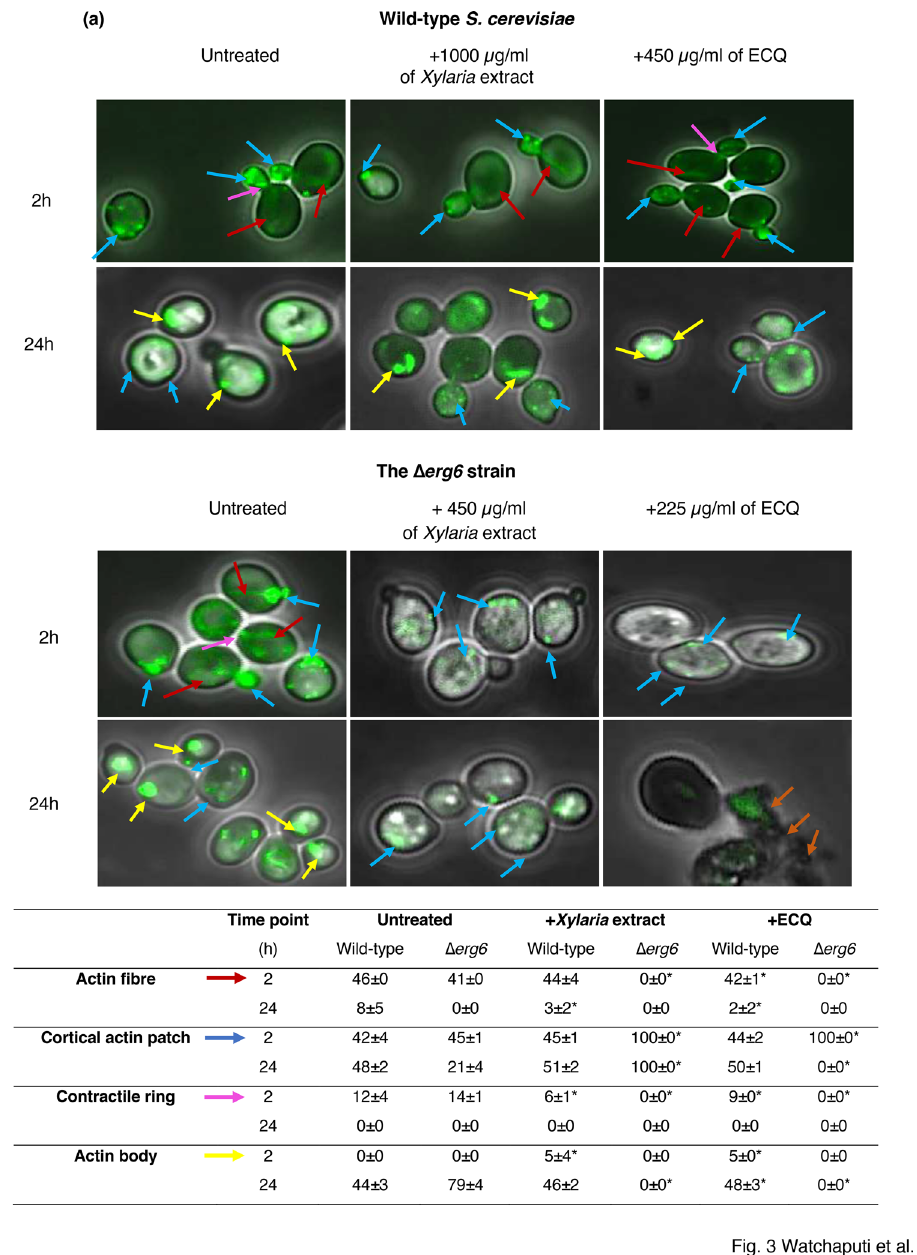
Figure 3. Effect of Xylaria extract and ECQ on actin cytoskeleton organization ( a ) and cell membrane integrity ( b ) in the wild-type S. cerevisiae and the ∆ erg6 strains. Blue arrows indicated cortical actin patches; red arrows indicated actin fibre; yellow arrows indicated actin body; and orange arrows indicated cell breakage. Error bars represent standard error of the mean (SEM) (* p < 0.05, using one-way ANOVA compared to the untreated